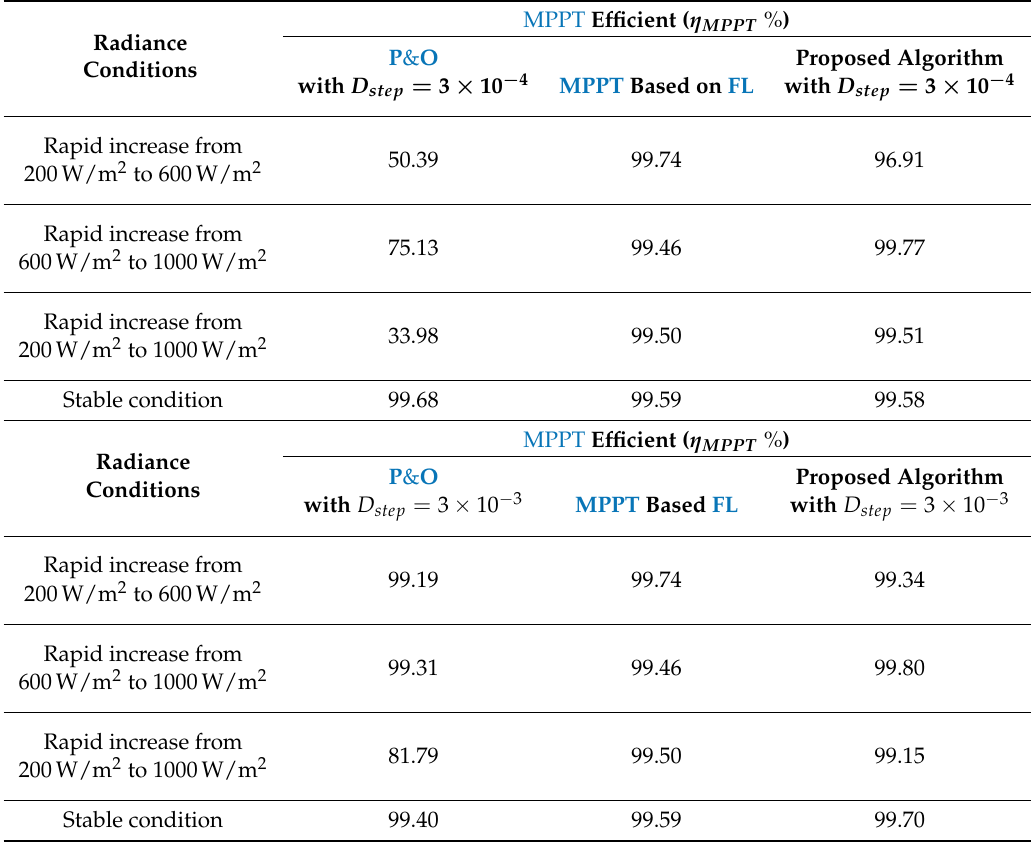
Table 4. Comparison of the tracking efficiency for different MPPT techniques under various changing conditions of